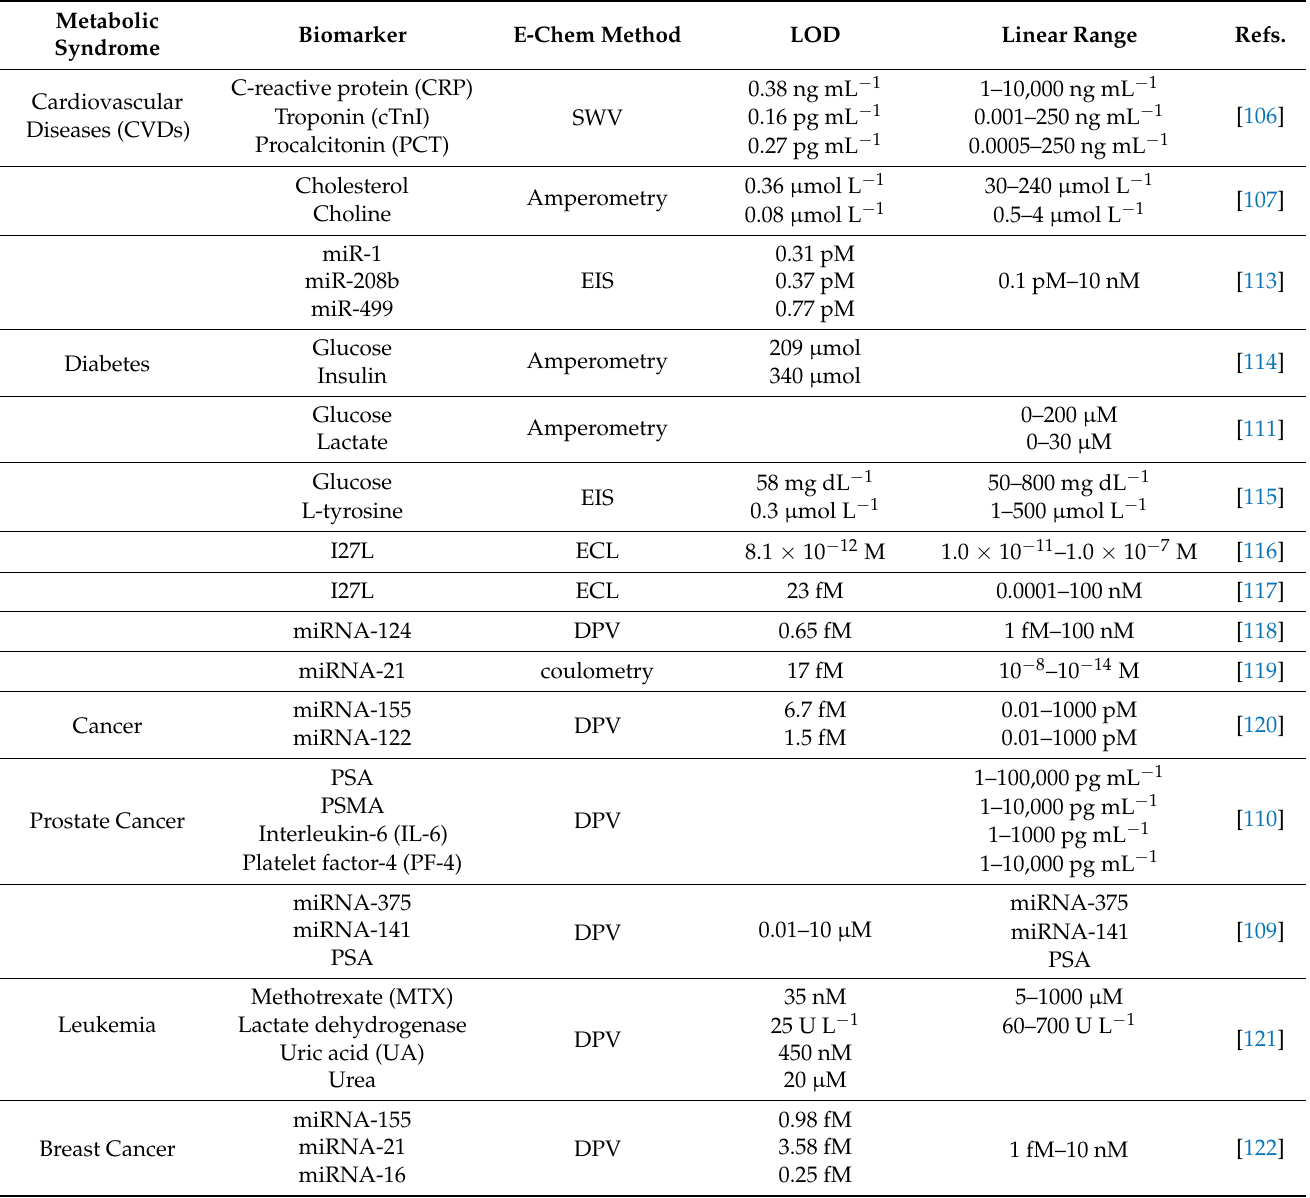
Table 2. Electrochemical sensors for multiplexed detection of biomarkers for metabolic